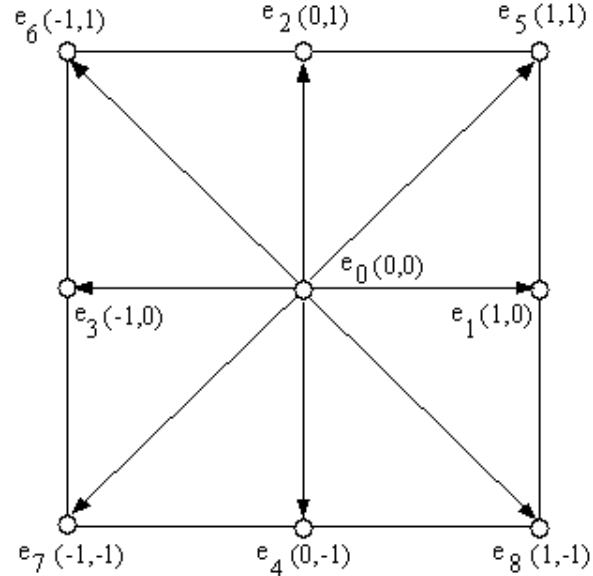
Fig. 2. Discrete velocity vectors in suppose of the D2Q9